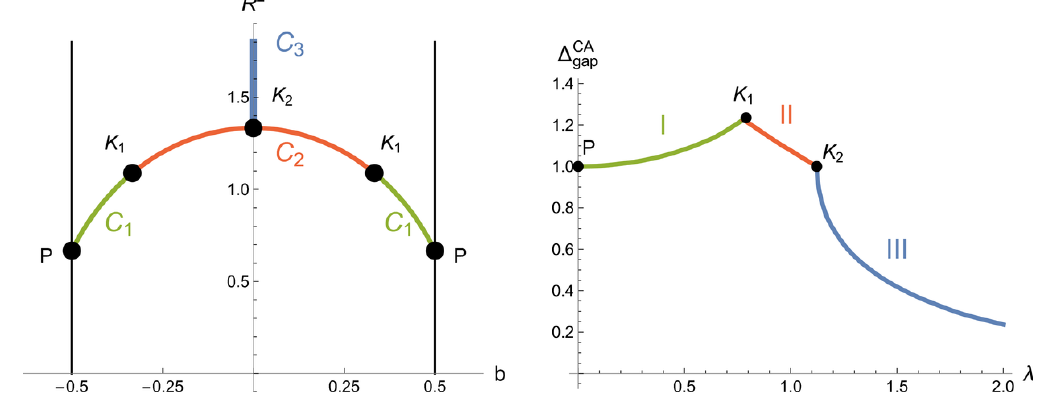
= (2 ; 2) T 2 = Z 3 orbifold theory, N b + 1. Right: the numeri- (cid:24) (cid:22) (cid:30) (cid:22) (cid:30) (cid:30) 1 (cid:30) 1 . The three real one-dimensional curves (cid:0) 1 (cid:0) 1 h 3 3 3 3 i